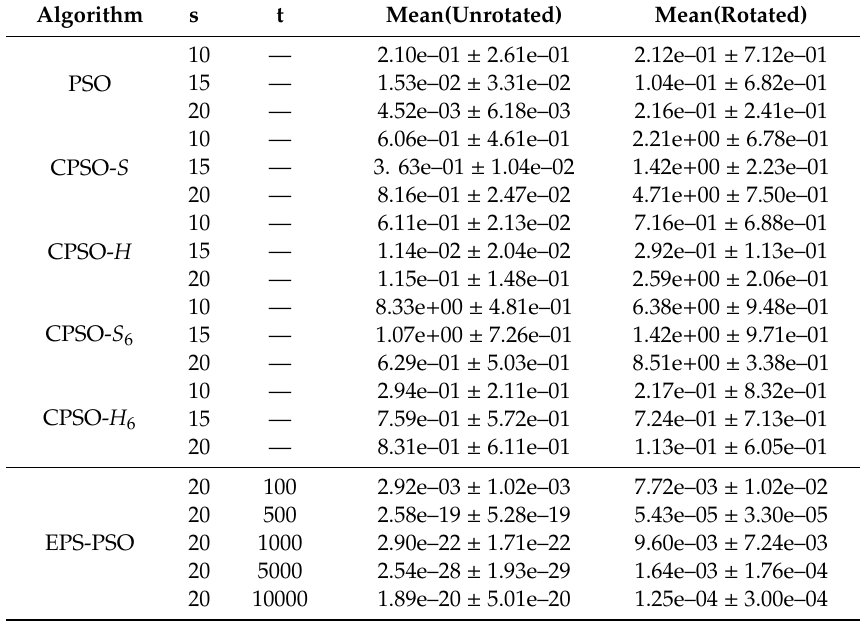
Table 2. Computational results of Rosenbrock obtained by using 6 PSO-based algorithms after 2 × 10 5 function evaluations, averaged over 50 independent